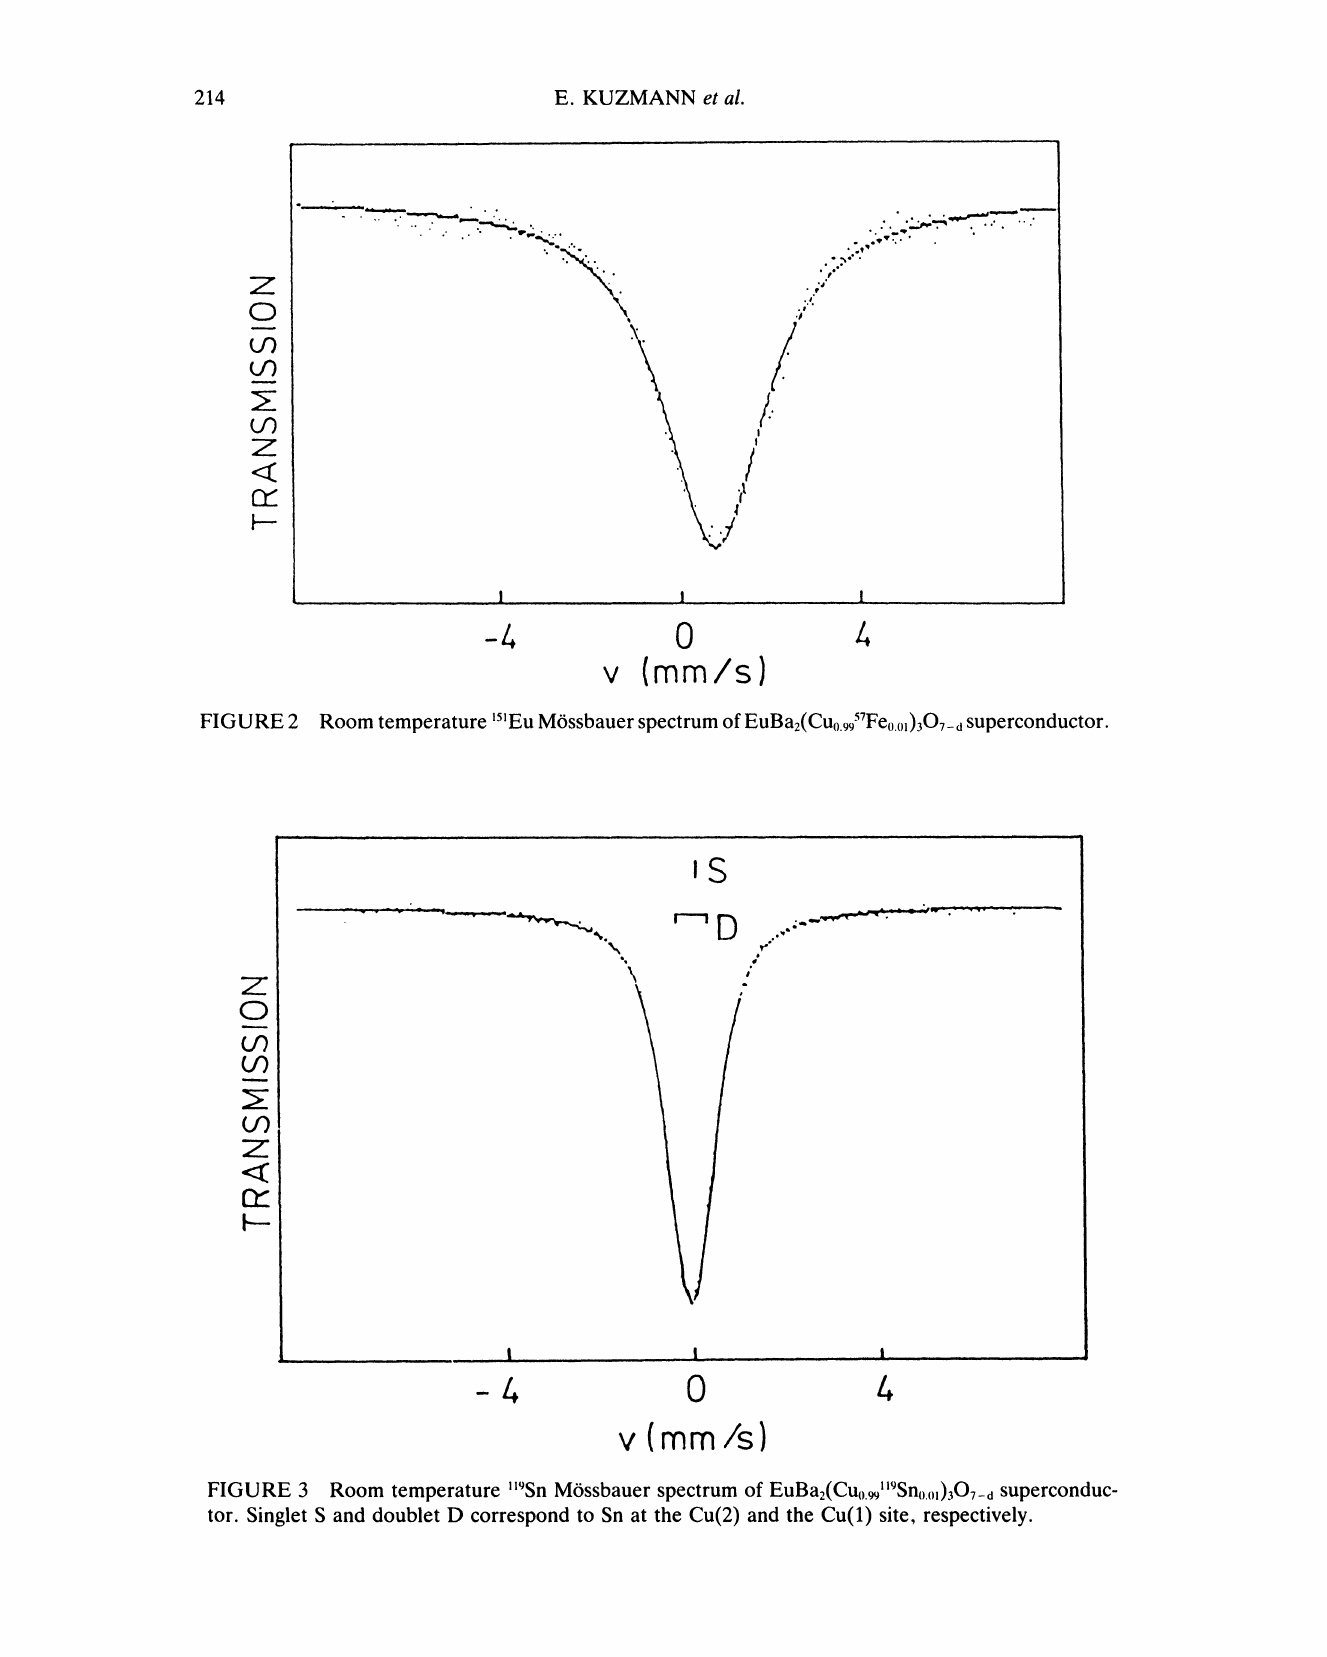
tor. Singlet S and doublet D correspond to Sn at the Cu(2) and the Cu(1) site,